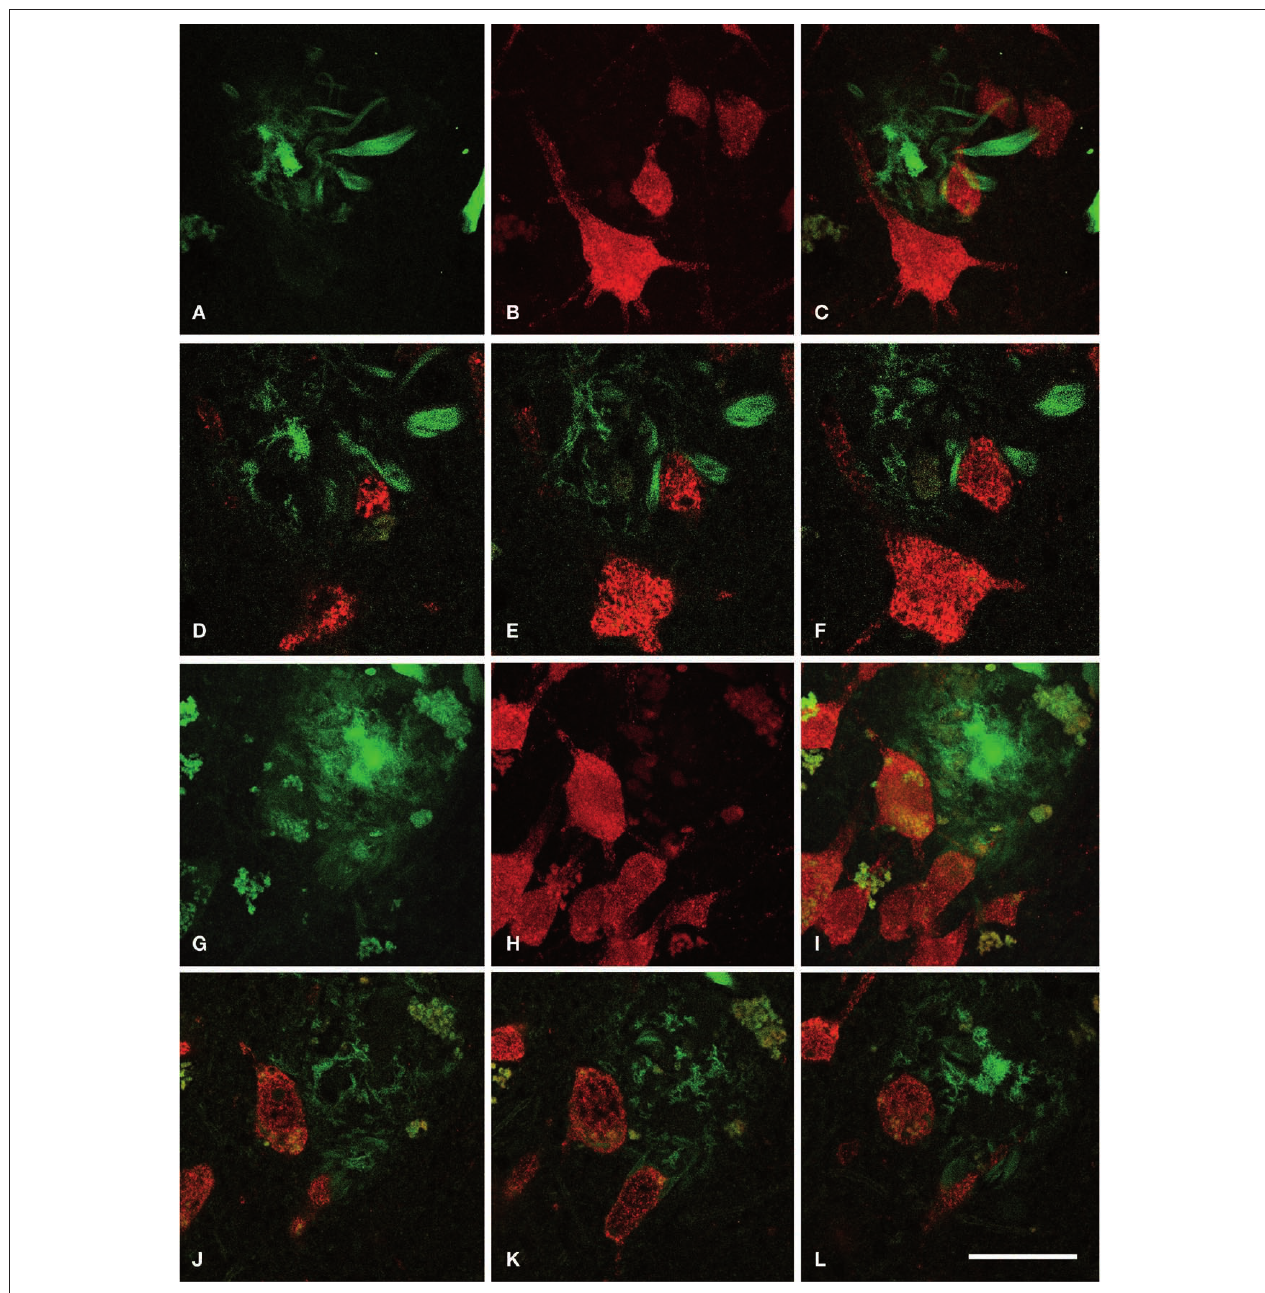
FIGURE 6 | Series of confocal images from patient P2 of two plaques (A–F) and (G–L) in contact with neurons doubled labeled for NeuN (red) and Thiofl avine-S (green). (A–C) Represent stacks of 11 optical sections separated by 1 µm in the z -axis (total 9 µm). (D–F) Single optical sections of the plaque